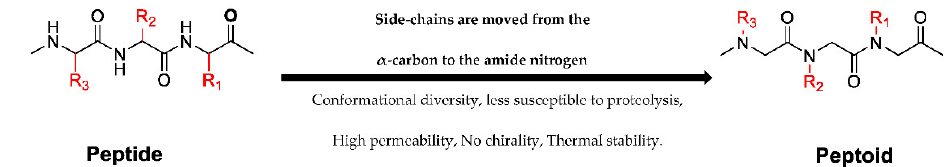
Figure 1. The difference between peptide and peptoid in terms of configuration and features.